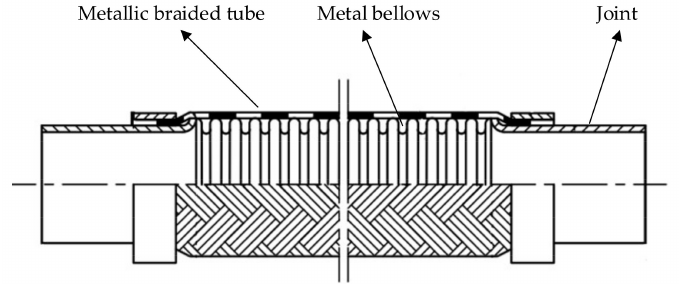
Figure 1. Schematic diagram of the braided corrugated hose.